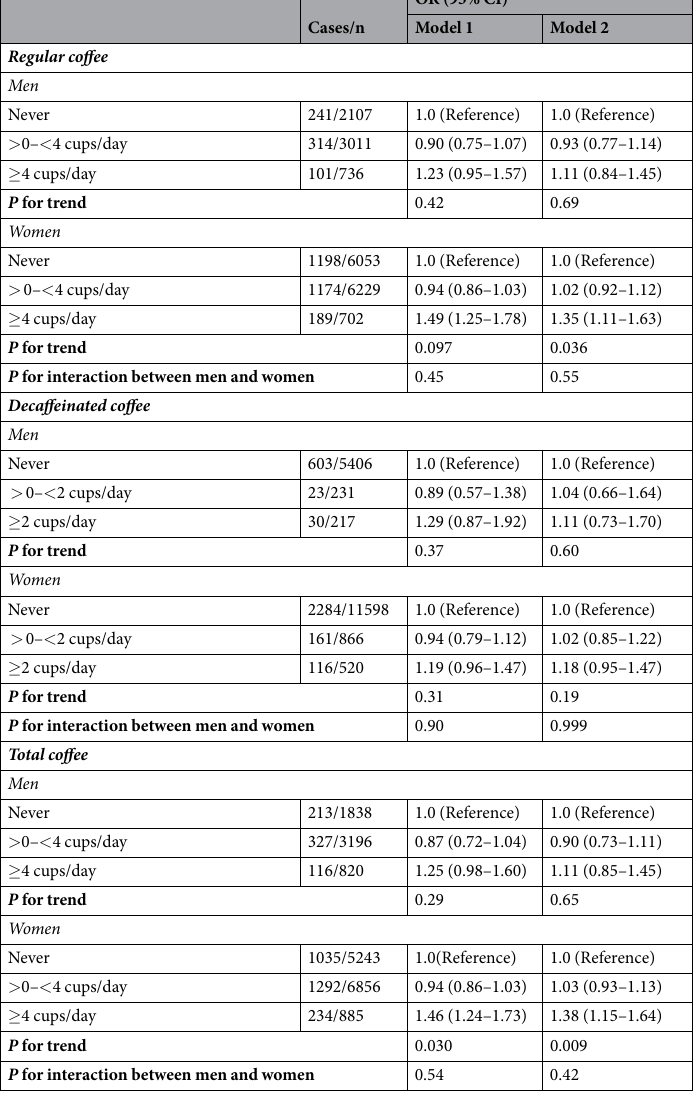
Table 3. Associations between coffee consumption and major depression risk among populations in Atlantic Canada. Model 1, adjusted for age. Model 2, further adjusted for ethnicity, education, province of residence, smoking status, alcohol drinking, self-reported cardiovascular disease and diabetes, healthy eating index (in tertiles), total physical activity (in MET-min/week tertiles), and BMI based on model